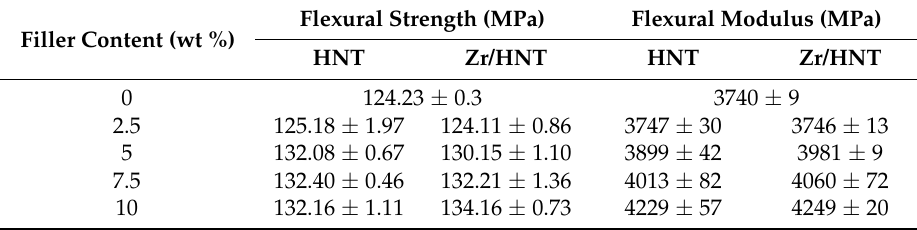
Table 3. Flexural strength and flexural modulus of the nanocomposites with HNT and Zr/HNT fillers. Flexural Strength Filler Content (wt %)